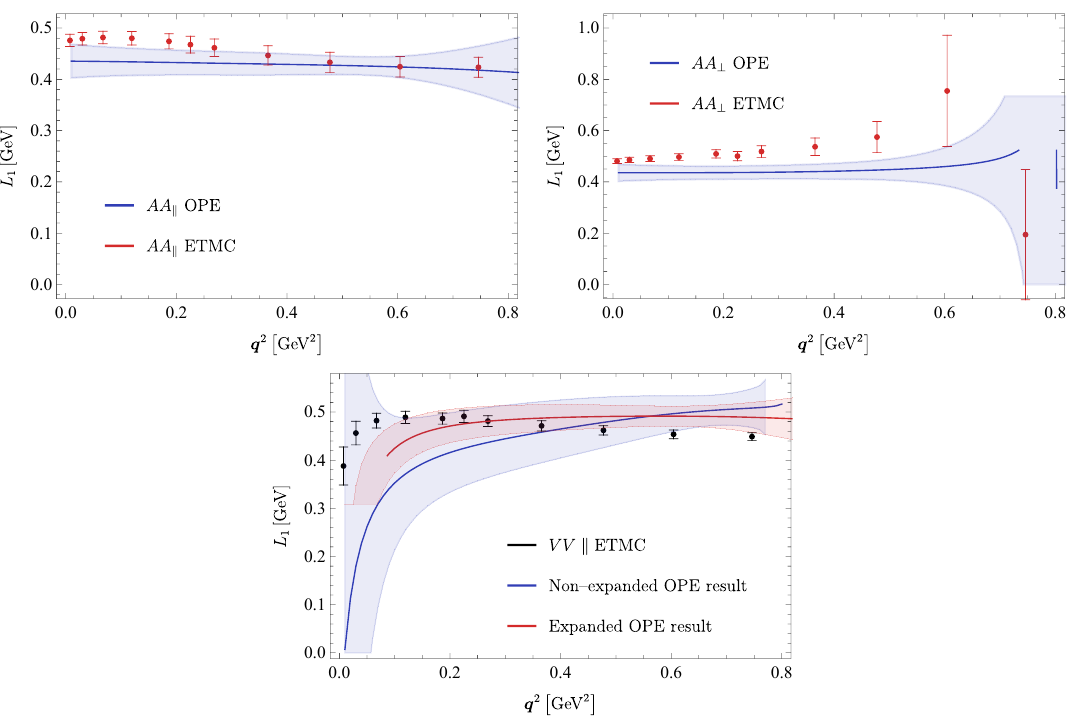
Figure 25 . Differential first lepton moments computed with a sigmoid approximation to the kernel with σ = 0 . 12 m B . The plots show the comparison between OPE and ETMC